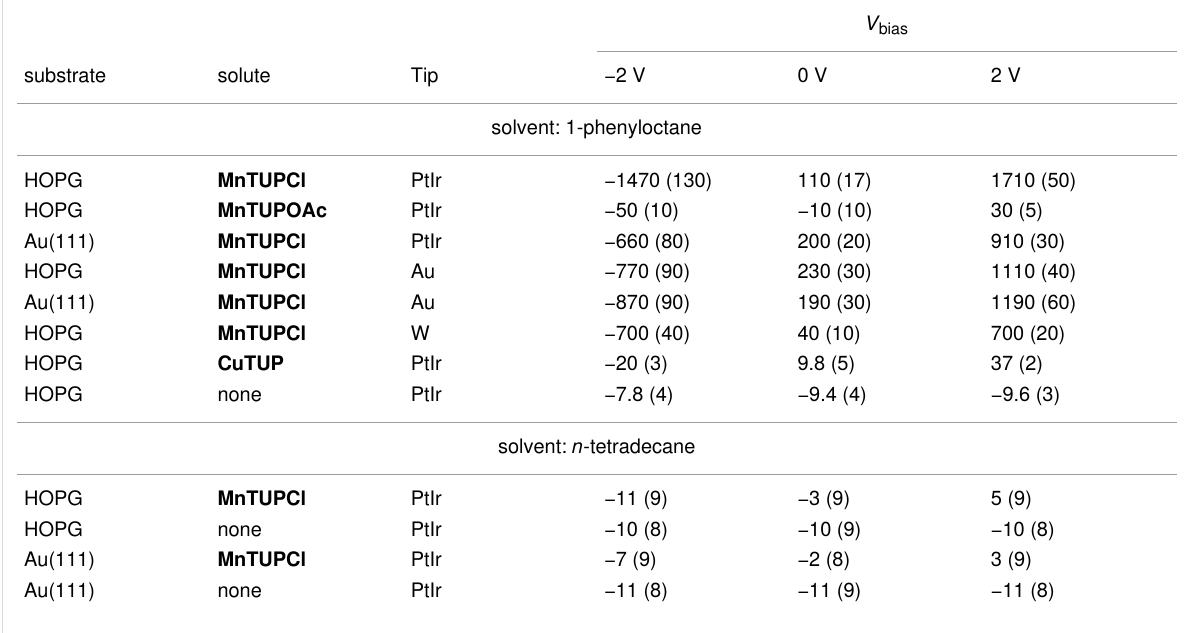
Table 1: Measured currents (in pA) between the tip and the sample in the modified liquid-STM setup as a function of the applied bias voltage ( V bias ). Porphyrin concentrations were 1 × 10 − 4 M, except for MnTUPOAc and CuTUP where a concentration of 1 × 10 − 3 M was used. Numbers between brackets indicate uncertainties (±1